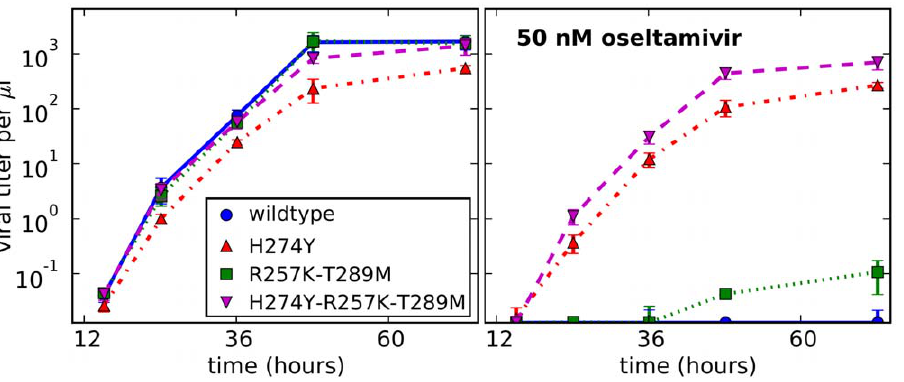
Figure 5. Growth in tissue-culture of pandemic H1N1 variants carrying neuraminidase mutations. The plot at left shows growth in media lacking oseltamivir, while the plot at right shows growth in media containing 50 nM oseltamivir. Viruses contain all genes from the A/ California/4/2009 strain with the T197A mutation to hemagglutinin, with the exception of the PB1 segment which is engineered to carry GFP. MDCK- SIAT1-CMV-PB1 cells were infected with the viruses at initial multiplicities of infection of 5 | 10 { 4 infectious particles per cell. At the indicated times, viral supernatants were harvested and titered on fresh cells. Shown are the mean and standard error for four replicates.